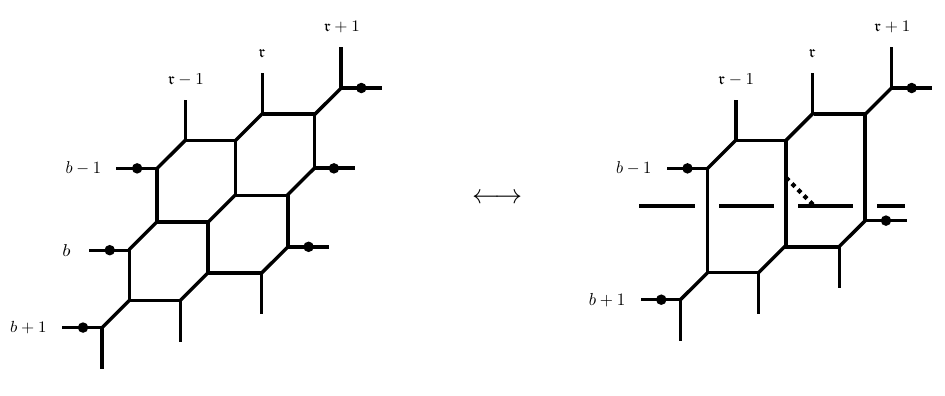
Figure 3 . The geometric transition operated on the preferred direction. The horizontal axis is compacti(cid:12)ed and the dots indicate the preferred